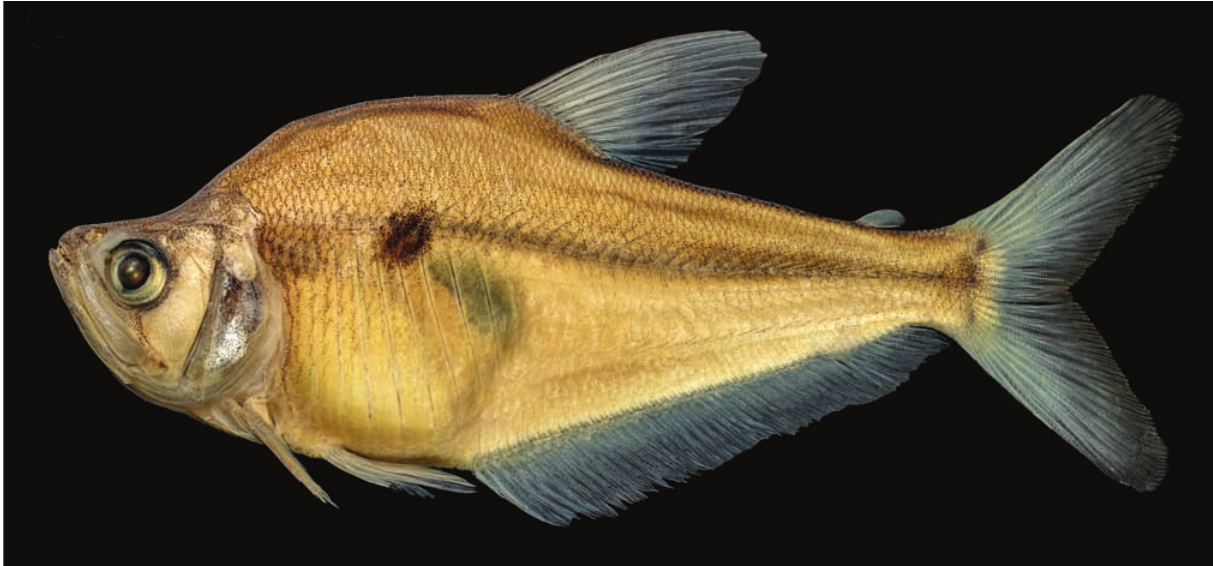
Fig. 6. Charax apurensis , MZUSP 110669, female, 104 mm SL.